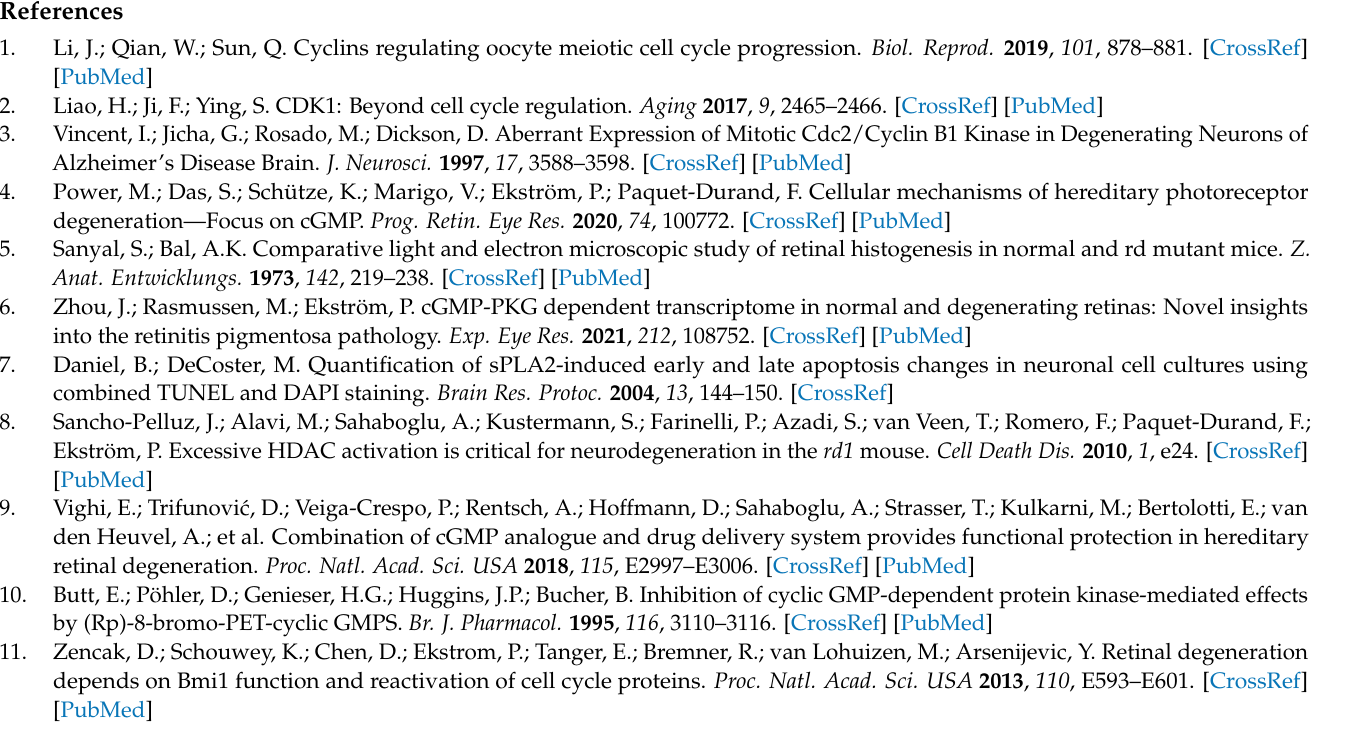
Figure S4. Immunostaining of CDK1 expression (green) within ONL of a P11 retinal explant from